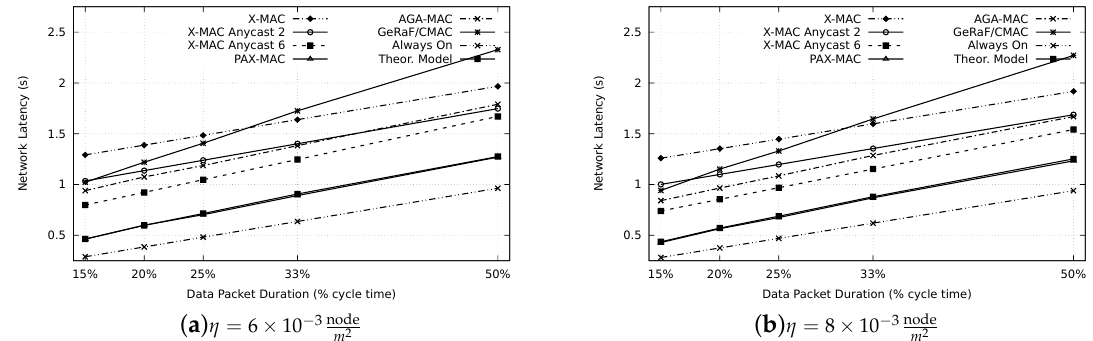
Figure 8. Latency for six different protocols compared to an always on network and the theoretical performance of the PAX-MAC. Source to destination distance set to 650 m. For all measurements, confidence interval shorter than ( x + 0.05, x − 0.05 )